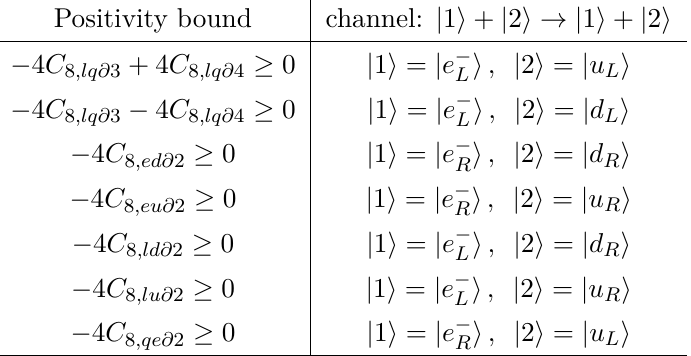
Table 1 . Elastic positivity bounds for the operators (2.5)–(2.11). The right column shows the scattering channel for the corresponding elastic